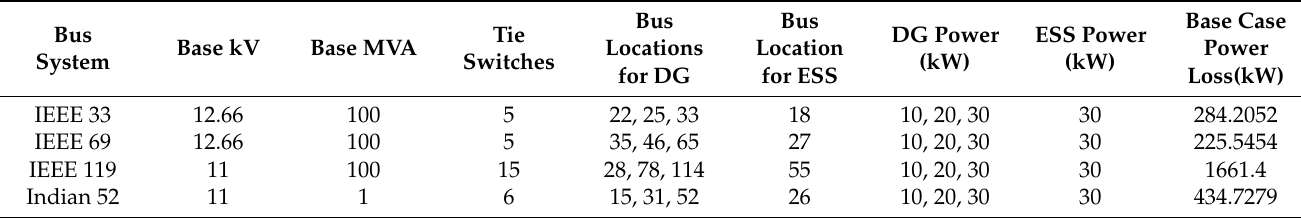
Table 4. Specifications of the test